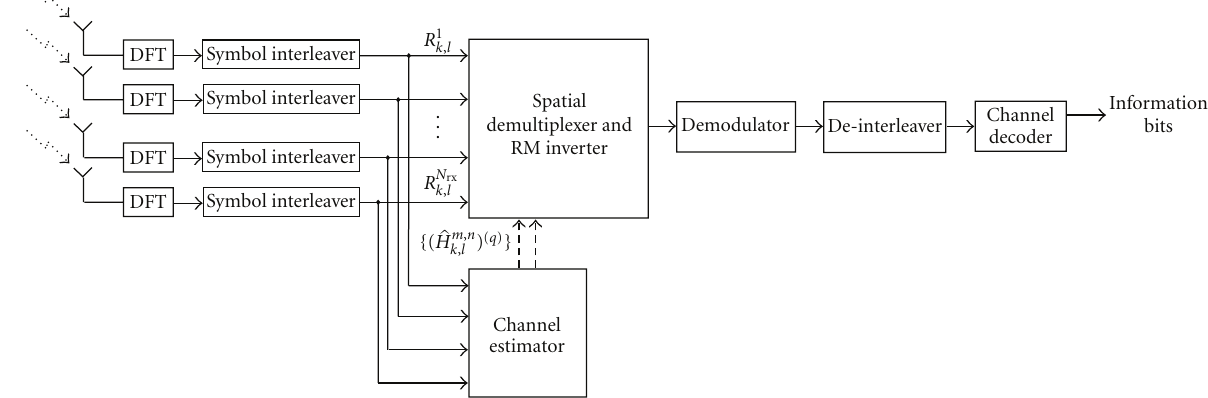
Figure 3: Receiver structure.